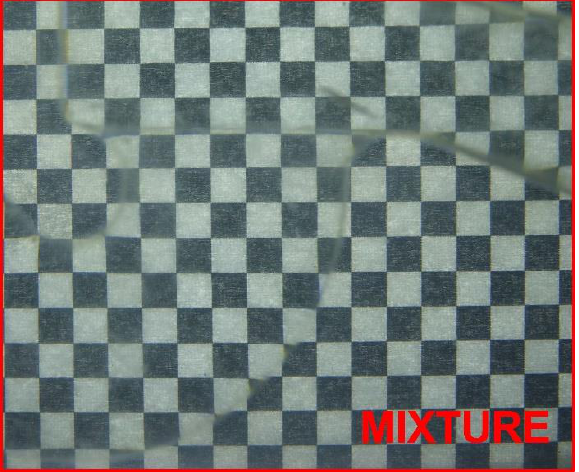
Fig. 3. Visual inspection of the optical deformation in the measured area using water-glycerine mixture (1.41 Ri) as the working